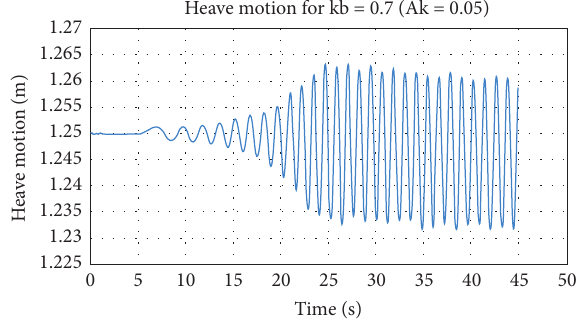
Figure 9: Time history of the heave motion of the pontoon at Ak � 0 . 05 and kb � 0 .